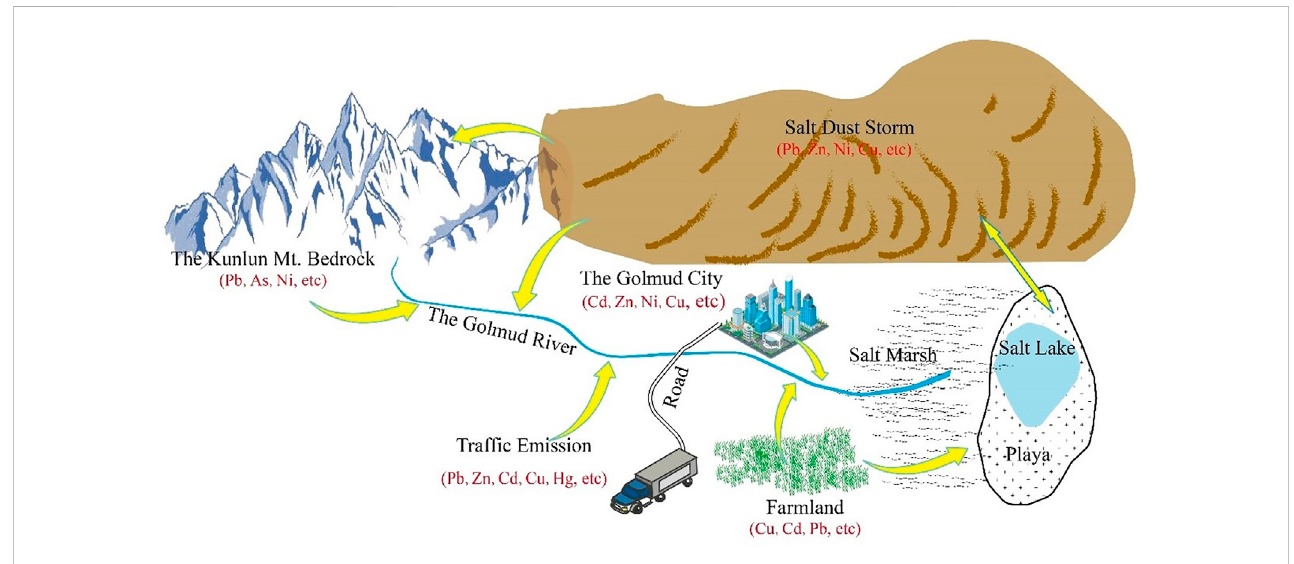
Cycling model of heavy metals in the surface